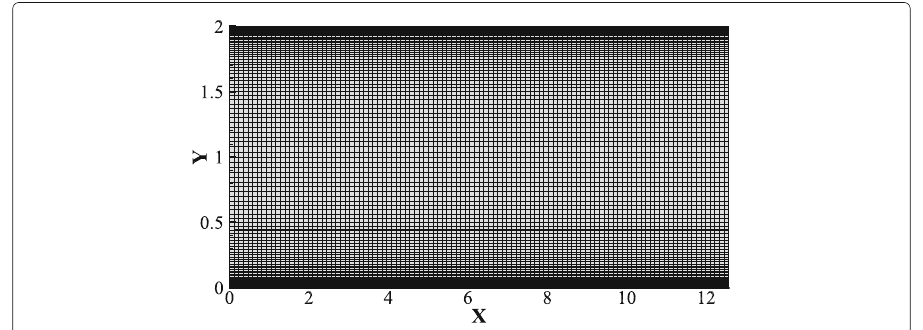
Fig. 9 The grid on X-Y plane for the turbulent plane Couette flow at Re τ =